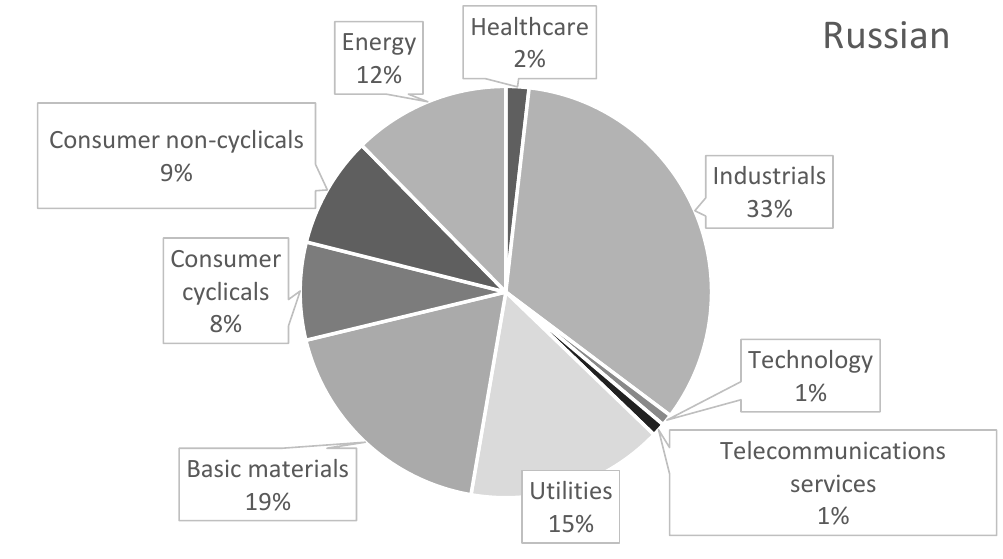
Figure 1a. Industrial affiliation of companies